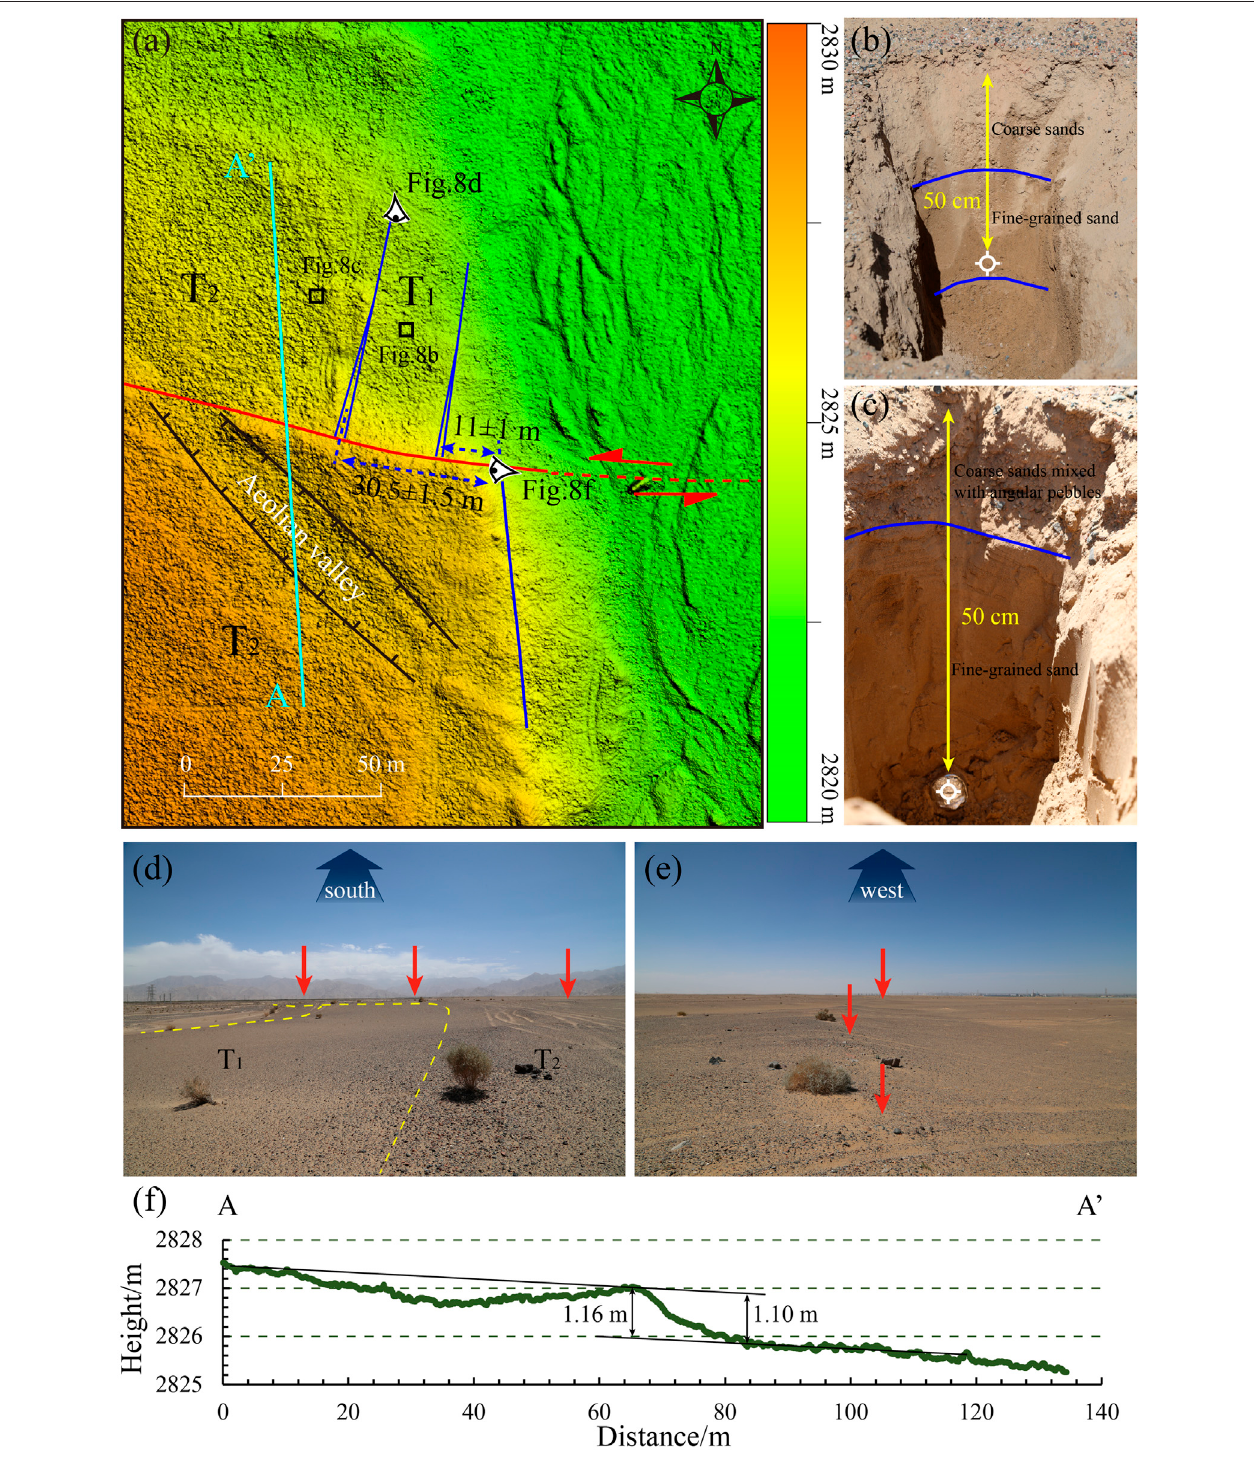
FIGURE 8 | (A) DEM data showing displaced landform at the Hongliugou Site. Red bold line represents the active fault trace, and red dotted line indicates conjectural fault trace. A-A ’ represent the location of topographic pro fi les in Figure 8F . The small black boxes indicate the location of samples. (B,C) OSL sampling photo. Sample site is shown in Figure 8A . (D,E) Field photos of scarp and left-laterally offset terraces. Red arrows indicate conspicuous fault scarps.